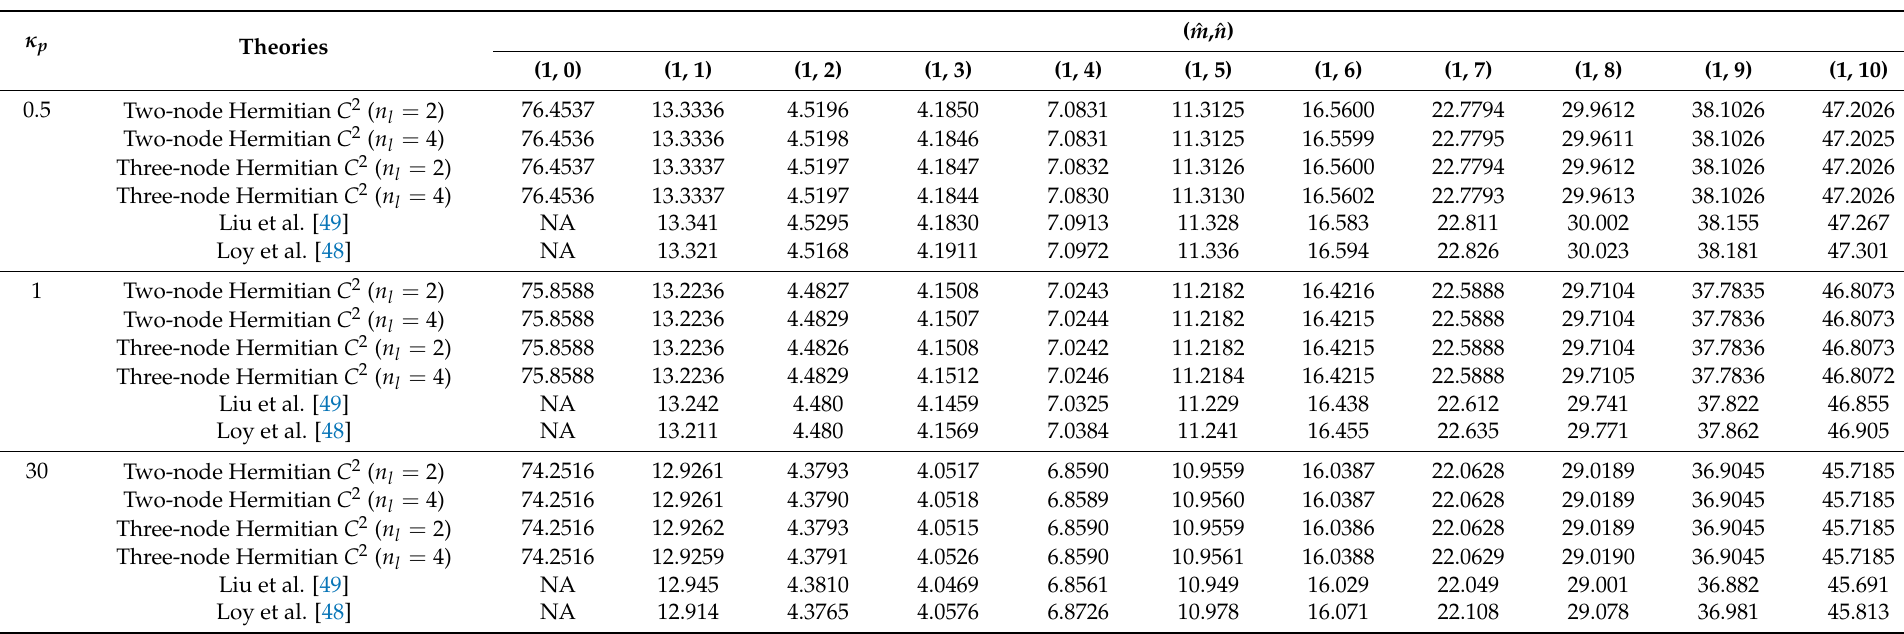
Table 2. Convergence and validation studies for the natural frequencies (Hz) of simply-supported FG cylindrical macroshells obtained using the two-node